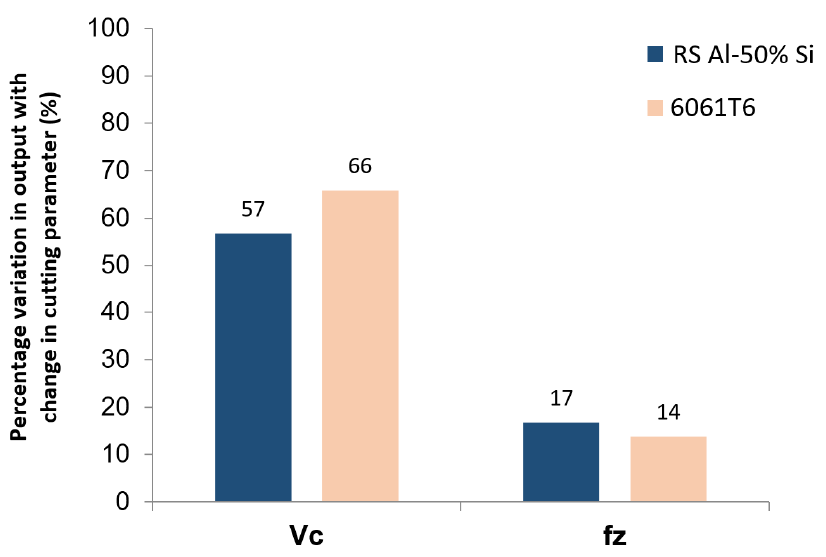
Figure 13. Percentage variation in roughness with a change in the cutting parameter and workpiece